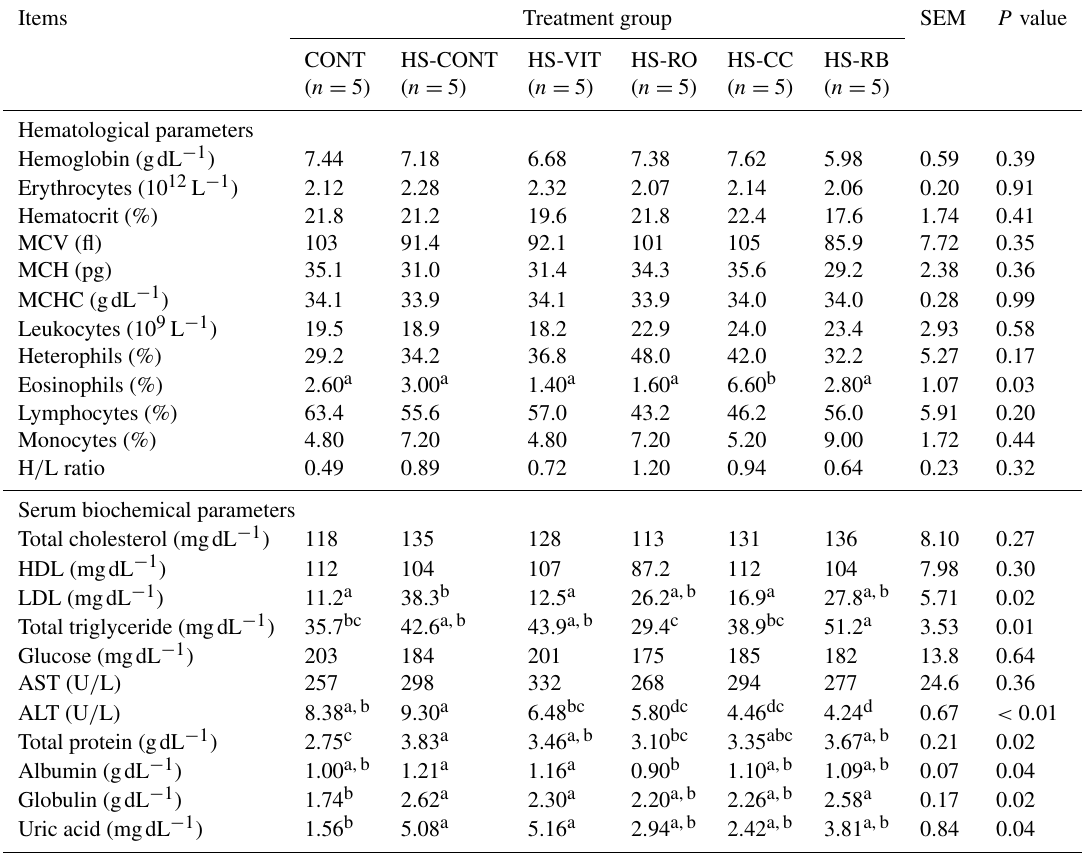
Table 5. Effect of dietary supplementation on hematological and biochemical parameters of broilers reared under normal or HS conditions. Items